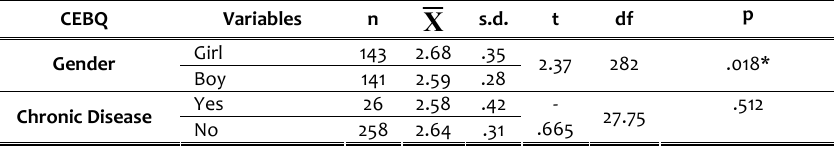
Table 4. Results of t-test regarding the CEBQ total scores and the children’s gender and presence of chronic